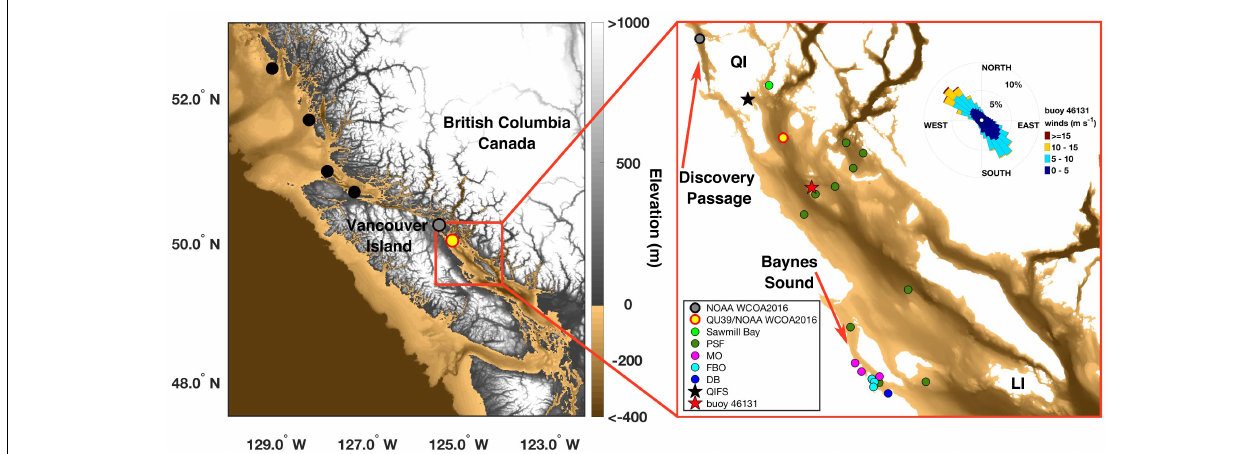
FIGURE 1 | Sampling locations on the British Columbia (BC) coast (left) and in the Northern Salish Sea (NSS; red box in left and right ). (Left) Shows locations occupied during the NOAA West Coast Ocean Acidification Cruise (WCOA2016) on the BC central coast (black), in Discovery Passage (gray), and in the NSS (red-outlined yellow circle). (Right) Shows locations in the NSS, defined here as waters extending from Quadra Island (QI) to Lasqueti Island (LI). The black star marks the Quadra Island Field Station (QIFS), and the red star marks Environment Canada weather buoy 46131. The Hakai Institute routinely samples the NSS station occupied during the NOAA WCOA2016 cruise (known as QU39). Additional sites were occupied by citizen science groups: light green dot = Sawmill Bay Shellfish Company, dark green dots = Pacific Salmon Foundation Citizen Science Program (PSF), magenta dots = Mac’s Oysters, Ltd. (MO), light blue dots = Fanny Bay Oysters (FBO), and dark blue dot = Vancouver Island University Deep Bay Field Station(DB). The wind rose in the right panel is hourly data from buoy 46131 collected between August 1997 to September 2018. Elevation shown in the left panel is from the Strait of Juan de Fuca 36 arc-second MHW Coastal Digital Elevation Model (https://data.noaa.gov/metaview/page?xml=NOAA/NESDIS/NGDC/MGG/DEM/iso/xml/541.xml&view=getDataView&header=none#Credit), and depth below sea surface in the right panel is from the British Columbia 3 arc-second Bathymetric Digital Elevation Model (https://data.noaa.gov/metaview/page ?xml=NOAA/NESDIS/NGDC/MGG/DEM/iso/xml/4956.xml&view=getDataView&header=none). The color scale for depth below sea surface is the same between the two